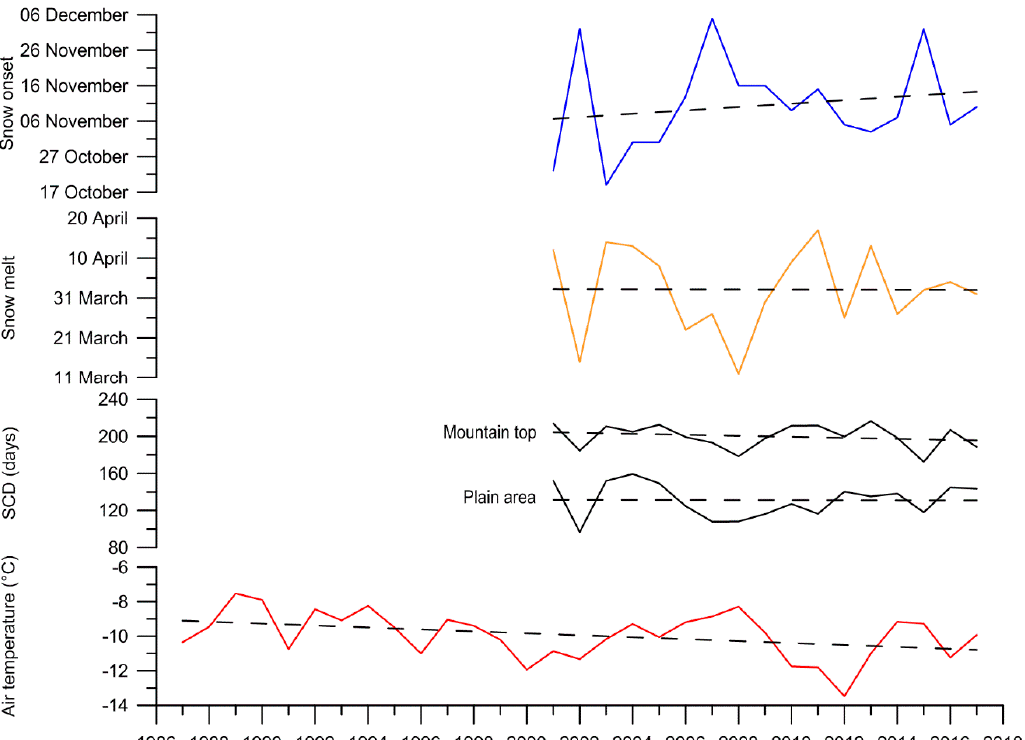
Figure 7. Trend analysis for the mean snow onset, snow melt, and SCD for 2001–2017, as well as monthly mean air temperature during snow season (ONDJFMA). Mountain peaks and plain areas were separated for SCD analysis. The temperature trend was analyzed using daily mean values from the nearest long-term observational site at the Chinggis Khan International Airport. There was no significant trend in each snow metric, while a slightly decreasing trend (p < 0.05) in air temperature was detected during the snow season, including intermittent and persistent snow periods.